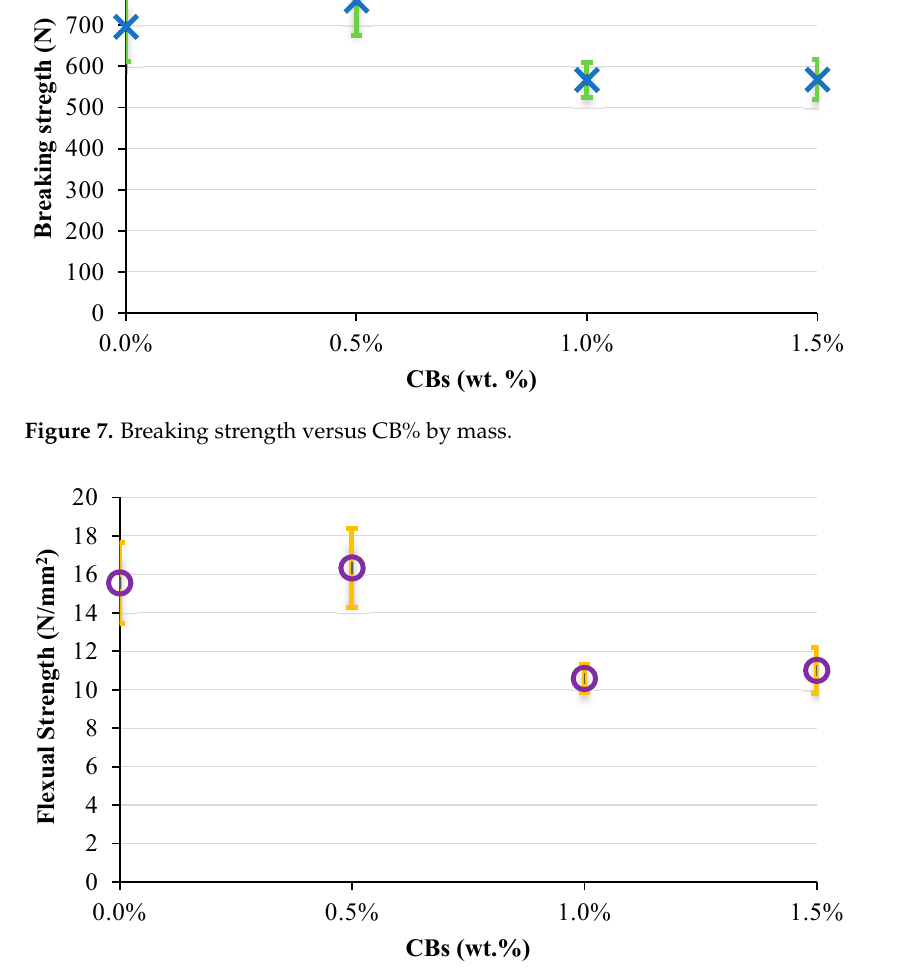
Figure 8. Modulus of rupture versus CB% by mass.